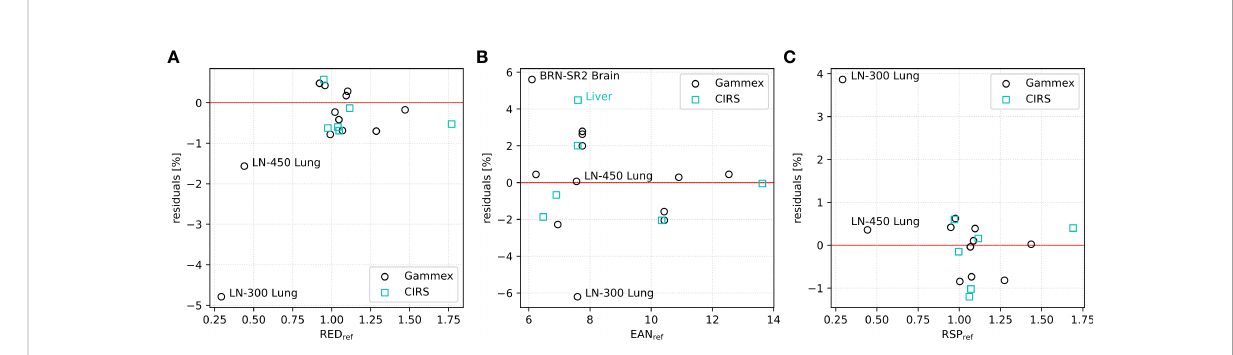
Figure 5 presents RMSEs of EAN evaluated for both phantoms using different low- and high-energy pairs of VMIs. RMSE values are displayed on a background of different shades of colors corresponding to the value. Similar patterns can be observed for the two phantoms: energy pairs sharing the same low-energy VMIs had nearly the same RMSE, although a minimum could still be identi fi ed. Errors of EAN using 40 keV low-energy VMIs were remarkably high, around 90% and 99% for the Gammex and the CIRS phantom, respectively. The low energy 60 keV had the best EAN accuracy, 50 keV the second. The EAN accuracy decreased with an increasing low energy. The lowest error, 2.90% for the Gammex phantom and 2.32% for the CIRS phantom, obtained with 60 and 180 keV VMIs, is marked by a red box in both plots. Like EAN, RMSEs of RSP are shown in Figure 6, and similar trends were observed: For the same low energy, RMSE barely varied despite the different choice of high energy. The RSP accuracy using the optimal energy pair 60 and 180 keV, 1.27% for the Gammex phantom and 0.71% for the CIRS phantom, is marked by a red box in both plots.